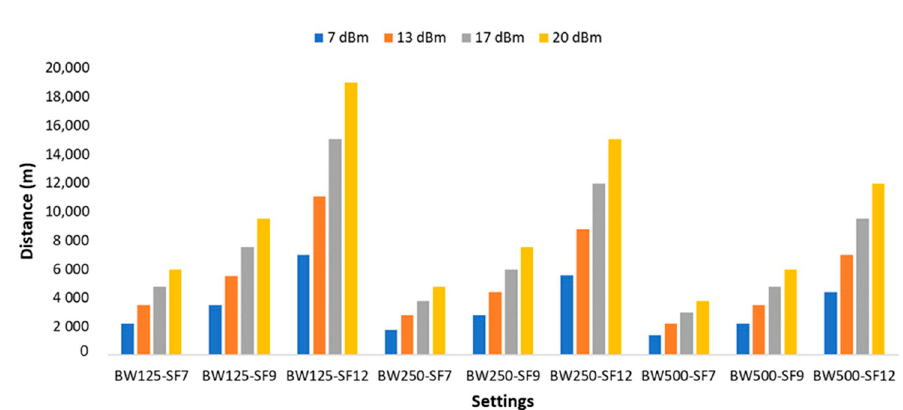
Figure 8. Maximum theoretical distance at 868 MHz for free space.